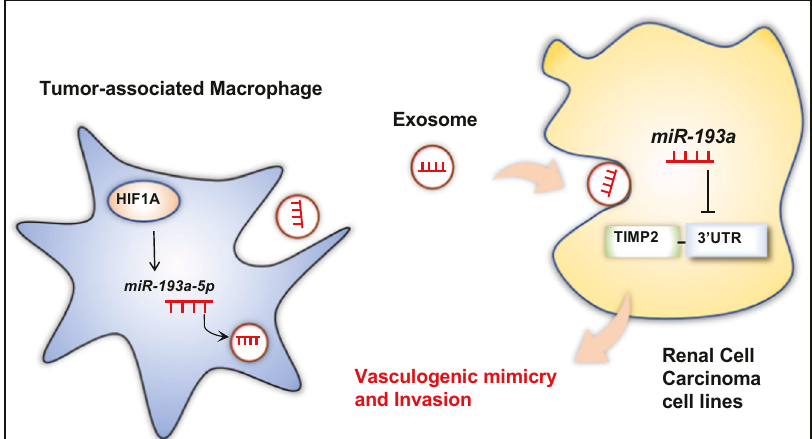
Fig. 7 Schematic diagram of how miR-193a-5p shuttled by TAM-derived exosomes downregulates TIMP2 expression in RCC cells to facilitate VM and invasion. The schematic diagram shows the regulatory mechanism how TAM-derived exosomes downregulate TIMP2 expression in RCC cells. The miR-193a-5p upregulated by HIF1A can be shuttled and secreted by TAM-derived exosomes to RCC cells. This TAM-derived exosomal miR-193a-5p downregulates TIMP2 expression to facilitate VM and invasion of RCC